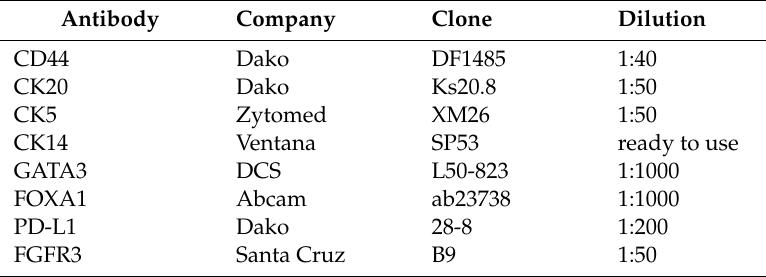
Table 5. Antibodies used for